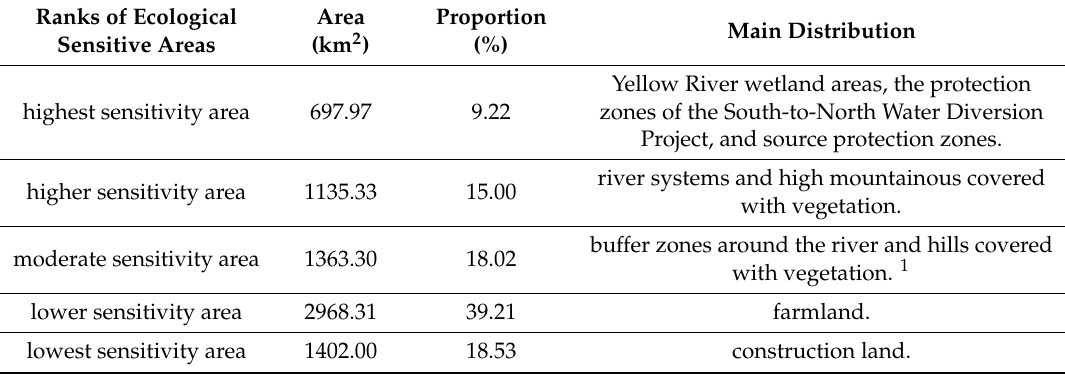
Table 3. Statistics on the sizes of ecological sensitive areas and their main distributions.